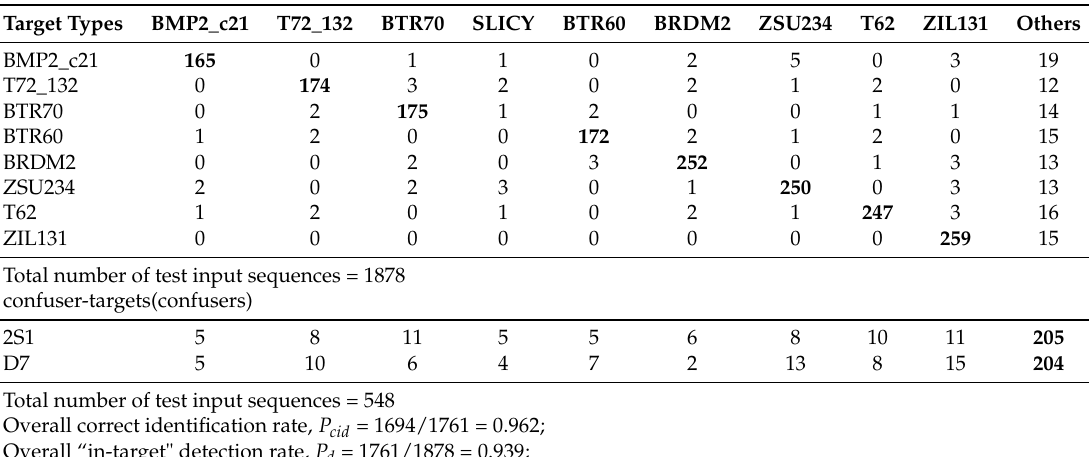
Table 7. Test results of MIBL-HMM testing with 3 ◦ aperture multi-domain HRRP